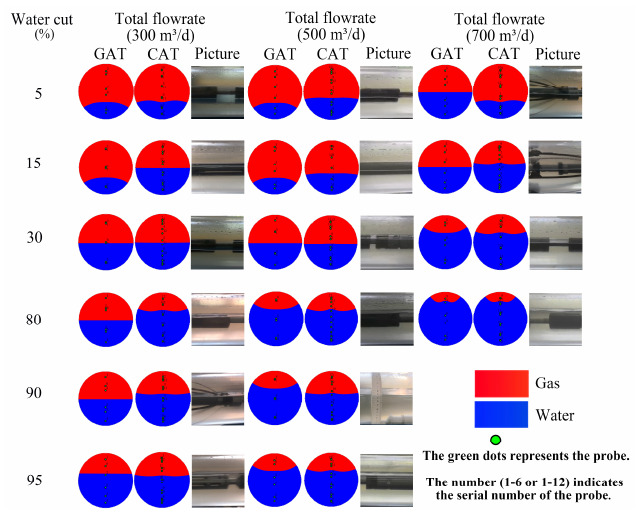
Figure 7. Projection diagram of GAT and CAT measurement points.